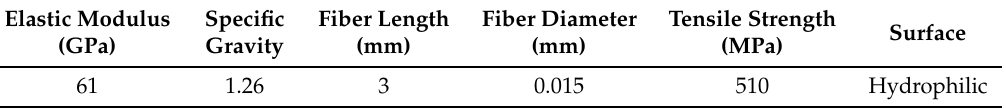
Table 5. Properties of latex.